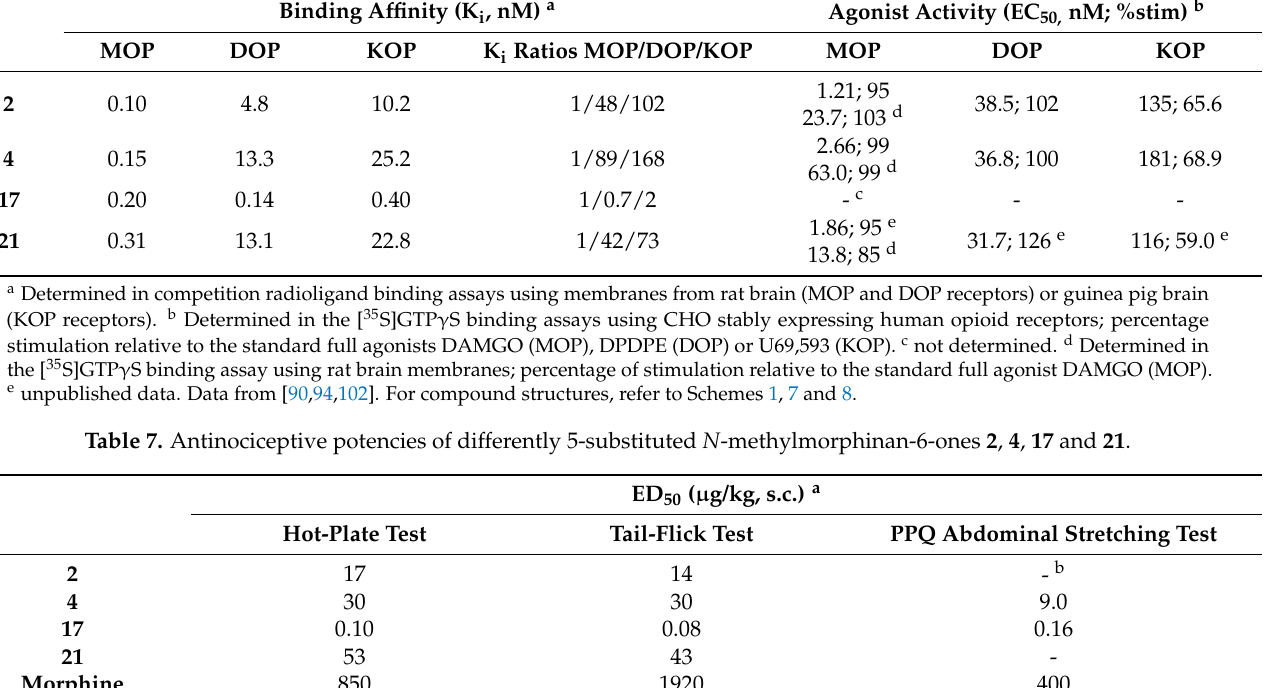
850 a Determined in mice after s.c. administration. b not determined. Data from [90,102]. For compound structures, refer to Schemes 1, 7 and